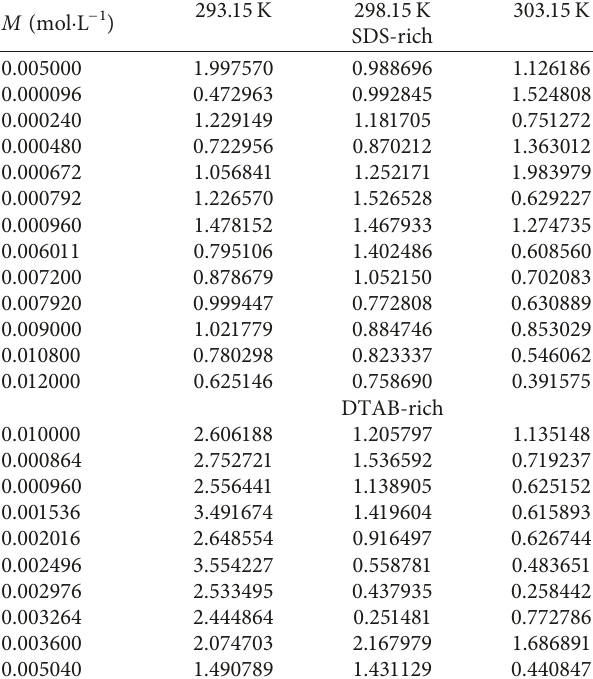
Table 7: Friccohesity shift coefficient (FSC) of SDS-rich and DTAB-rich surfactants in the aqueous medium at the three dif- ferent temperatures T � 293.15, 298.15, and 303.15K and at